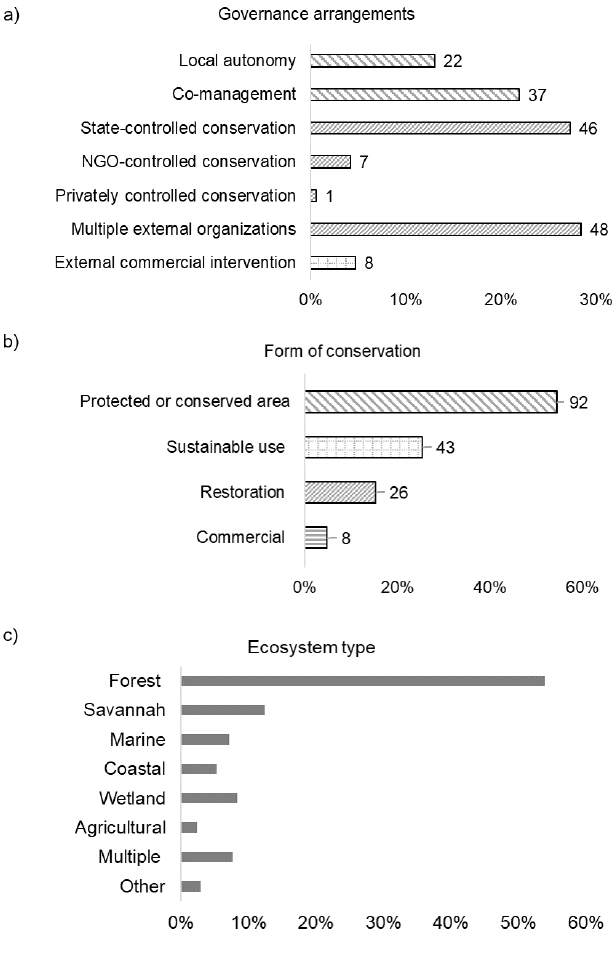
Fig. 2 . Sample of 169 study cases categorized by (a) governance arrangements; (b) the form of conservation or land use; and (c) ecosystem